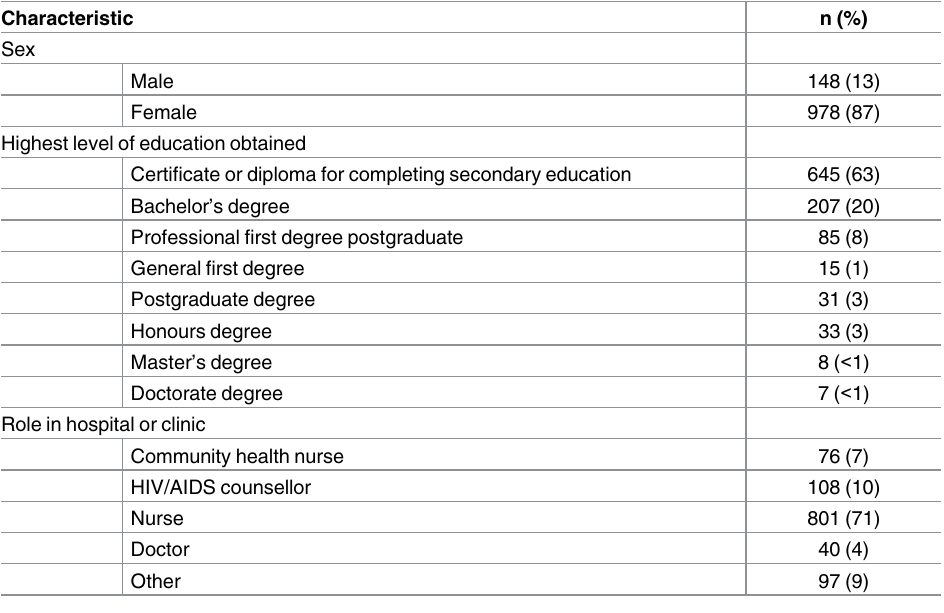
Table 1. Characteristics of survey respondents (N = 1164) * .